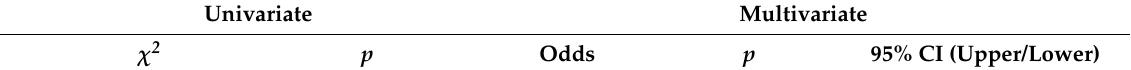
Table 6. Logistic regression analyses for the factors of RemL-C in female participants with T2DM. Univariate Multivariate